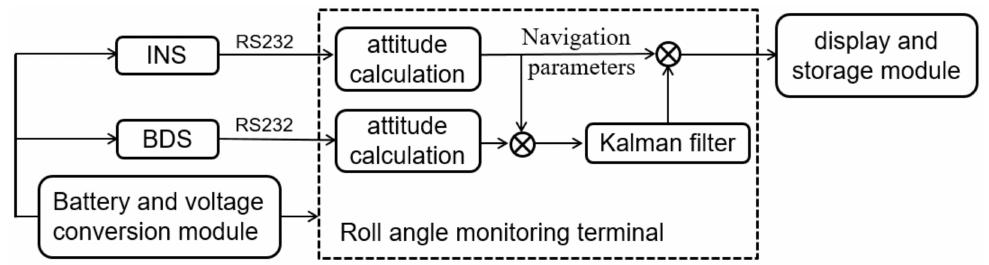
Figure 4. Structural diagram of the sensor fusion